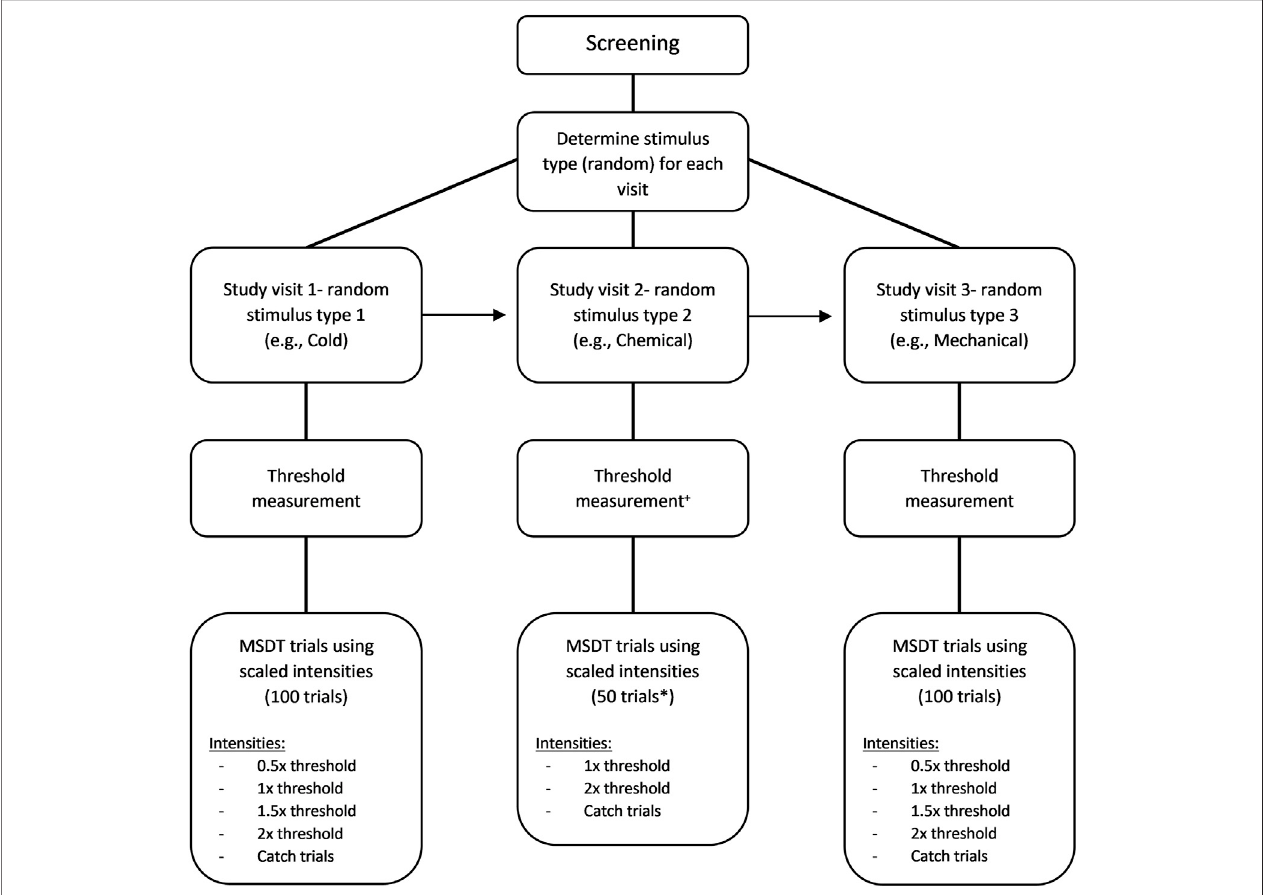
FIGURE 1 | Flow chart of the MSDT experiment. The order used in this example is cold ( fi rst visit), chemical (second visit), and mechanical (third visit) stimuli. + For chemical threshold measurement, mechanical threshold was measured fi rst followed by the chemical threshold with half of the mechanical threshold as the fl ow rate of chemical stimuli. * 50 trials were used only for chemical MSDT